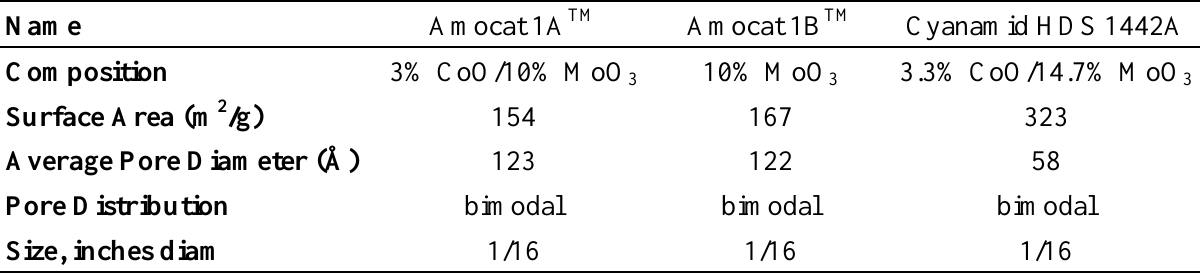
Table 9. Liquefaction catalysts for H-Coal